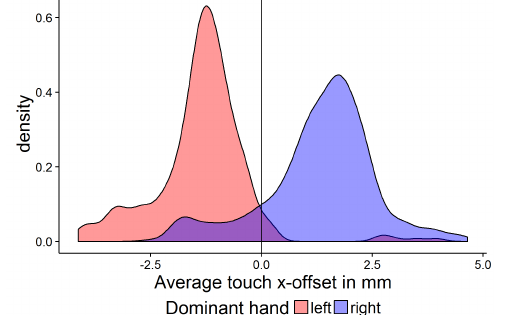
Figure 9. Distribution density of average touch x-bias from